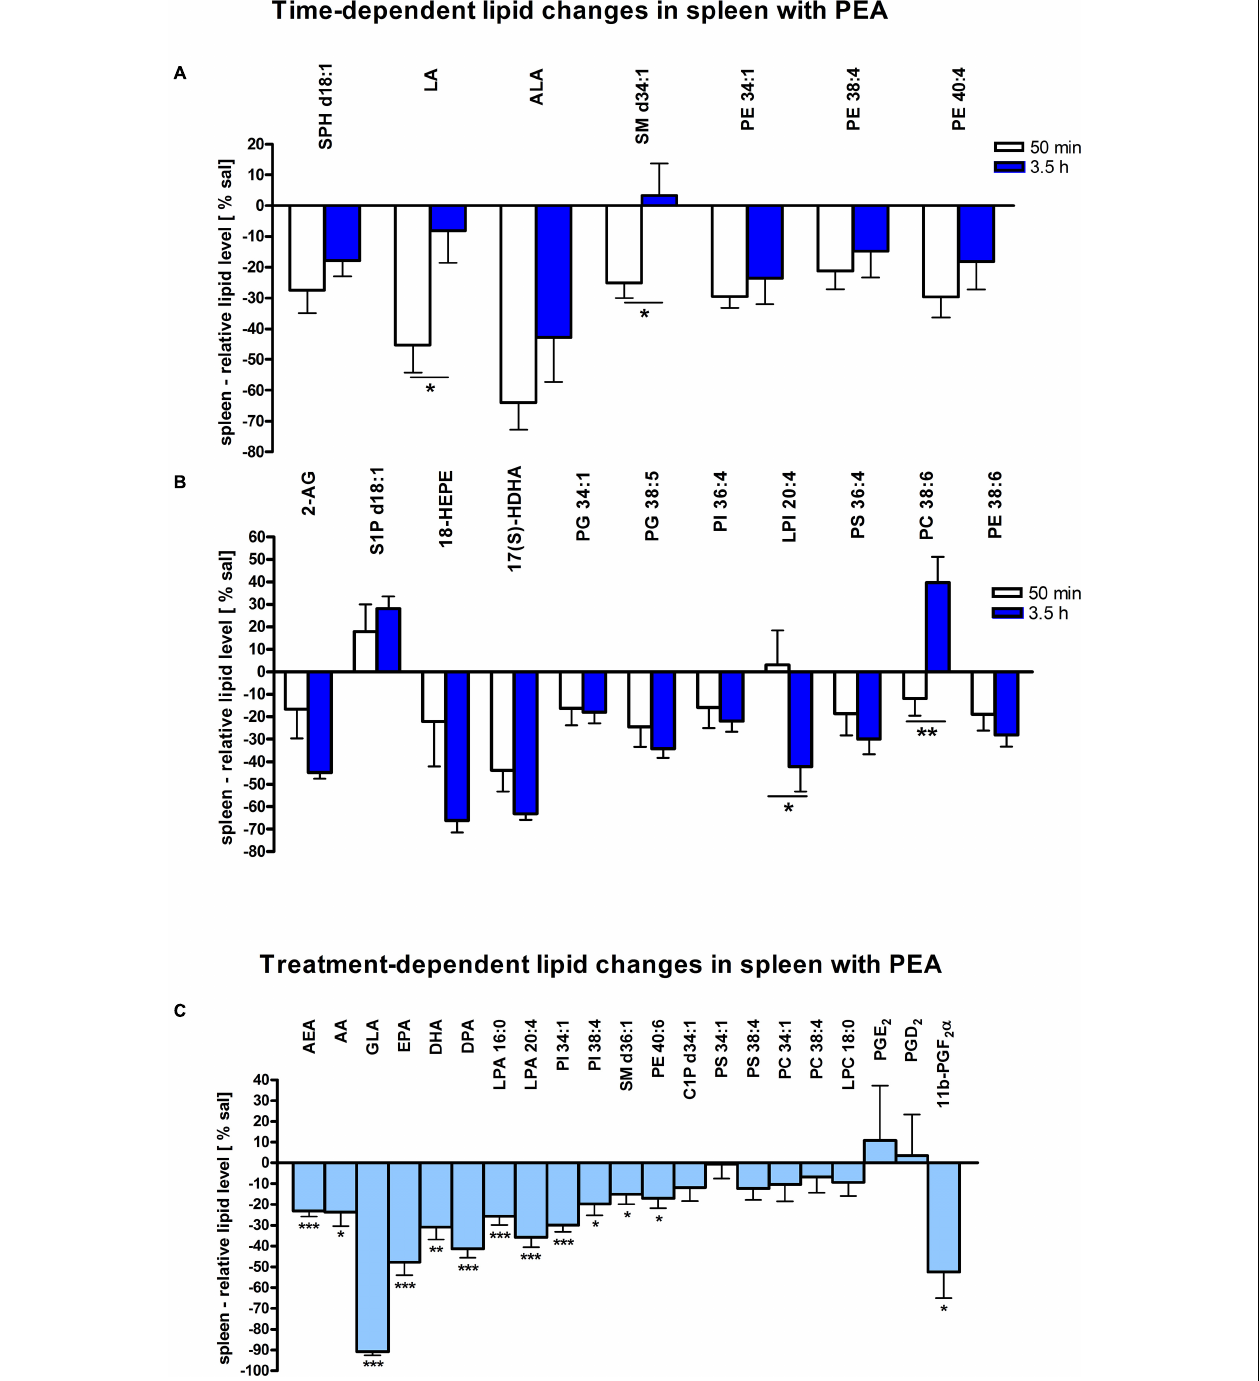
FIGURE 2 | Lipid levels of spleen after PEA treatment: relative lipid concentrations [normalized to the tissue weight (spleen, approximately 20 mg)] after PEA treatment as percentage of saline treated mice are shown and presented as mean value ± SEM. (A) Time point 1: time-specific lipid plasticity after 50 min of PEA treatment. Relative lipid levels for the two different time points are shown for reference, but only lipids significantly changing after 50 min of PEA treatment are depicted. (B) Time point 2: time specific lipid plasticity after 3.5 h of sub chronic PEA treatment. Relative lipid level for two different time points are shown and only lipids significantly changing after 3.5 h of PEA treatment are depicted. Significant differences between the time points were also detected and as they underline time specificity for these lipids, they were marked on the figure with ∗ . (C) Merged time points: PEA treatment effect on lipid plasticity. Changes for AA, PI 38:4, SM d36:1, PE 40:6 and 11 β -PGF 2 α are significant when pooling the time points. The remaining significantly changed lipids show significant changes for both time points, respectively. Data were considered significant at a p -value < 0.05, e.g., ∗∗∗ p < 0.001, ∗∗ p = 0.001 to 0.01; ∗ p = 0.01 to 0.05.